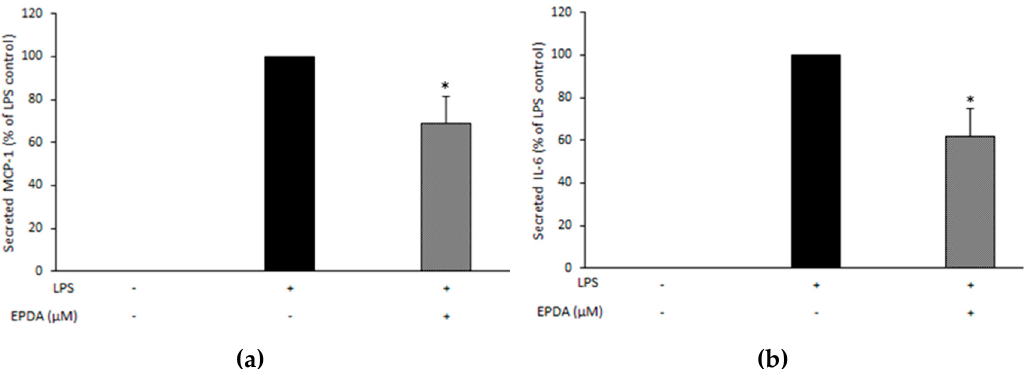
Figure 4. Effect of N -eicosapentaenoyl dopamine (EPDA) on the secreted chemokine monocyte chemoattractant protein-1 (MCP-1) ( a ) and interleukin-6 (IL6) ( b ) by THP-1 macrophages exposed to lipopolysaccharide (LPS). Cells were seeded in 24-well plates at 100,000 cells / well in the presence of PMA (100 nM). After overnight incubation, and replacing of PMA-containing medium with fresh medium, attached cells were rested for 24 h and then stimulated with (or without) LPS (10 ng mL − 1 ) and with (or without) EPDA (1 µ M) for 24 h. Cell supernatants were evaluated for secreted proteins using ELISA. Data are expressed as percentages of LPS control (black bar, set at 100%), and represent the mean of three independent experiments (each done in triplicate) ± SD. Average absolute values for MCP-1 and IL-6 with LPS stimulation (LPS control) after 24 h were 86 ± 5 and 213 ± 26 pg mL − 1 , respectively. Asterisks indicate significantly different mean values from those of control (* p < 0.05).